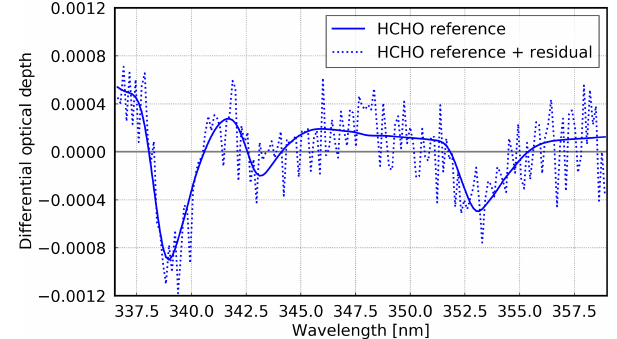
Figure 5. Example of a HCHO fit for 13 October 2016 at 14:38UTC (latitude: ∼ 10.1 ◦ N; longitude: ∼ 19.8 ◦ W). The SCD is 2.52 × 10 16 moleccm − 2 with a rms of 2.2 × 10 − 4 at 29.46 ◦ SZA and a viewing angle of 15 ◦